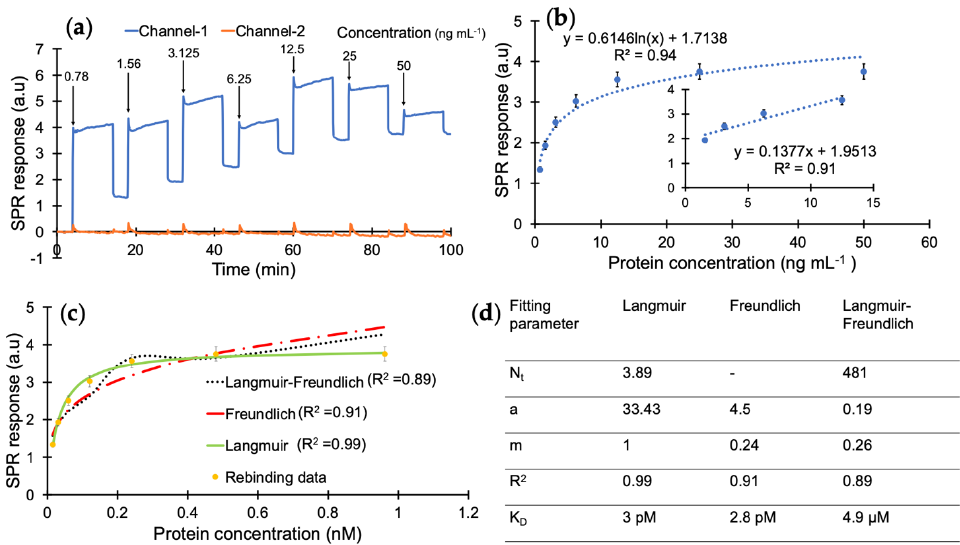
Figure 5. ( a ) Real-time SPR sensorgram of cumulative cTnI detection. ( b ) Concentration-dependent protein binding with a correlation coefficient of 0.94 and R 2 value of 0.91 for the linear range of 1.56 – 12.5 ng mL −1 . ( c ) Binding isotherm fittings for the interaction between the nanoMIPs and cTnI. ( d ) Binding isotherm fitting parameters obtained from Langmuir, Freundlich and Langmuir – Freundlich models.